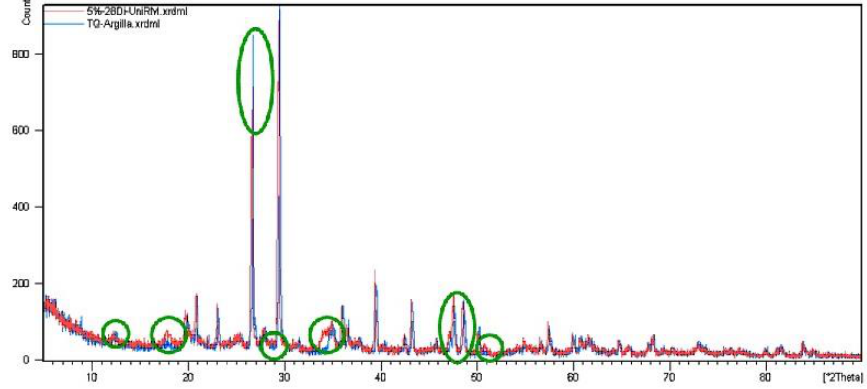
Figure 10. Overlay of TQ5 diffractogram at 28 d (red) and TQ0 diffractogram (blue).